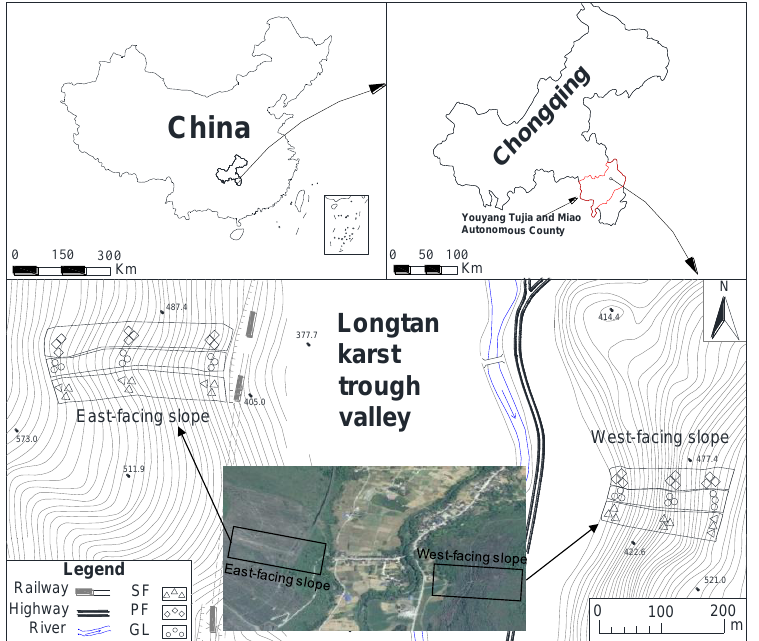
Figure 1. Location map of sampling sites. SF, secondary forest; PF, plantation forest; GL, grassland. LTV is located on the southeast wing of the Tongmaling anticline, where its axial area is dominated by Cambrian dolomite and Ordovician limestone, and the areas in the two wings of the anticline are Silurian sand shale and Permian and Triassic limestone, respectively [30]. LTV runs from northeast to southwest, with a total length of approximately 35 km and an area of 1677 km 2 , which is dominated by karst landform accounting for 76% of the total area [30]. The bottom area of LTV has a width ranging from 1 to 4 km with an elevation of 300–500 m above sea level, and the elevation of east to west wings of LTV varies from 900 to 1100 m above sea level with the slope gradient of 15–30 ◦ [30]. The bedrock stratum tendency on either side of the LTV is the same, while the slope aspect is the opposite. The relatively more shaded east-facing slope of LTV has the same dip direction with the bedrock stratum tendency, while the west-facing slope of LTV has inverse dip direction with the bedrock stratum tendency [31]. Since the severe water and soil losses usually occur on the slope presenting the same dip direction with bedrock stratum tendency [31], the east-facing slope has a higher rock bareness rate than that in the west-facing slope, which together results in severe rocky desertification accounting for 11% of the total area.